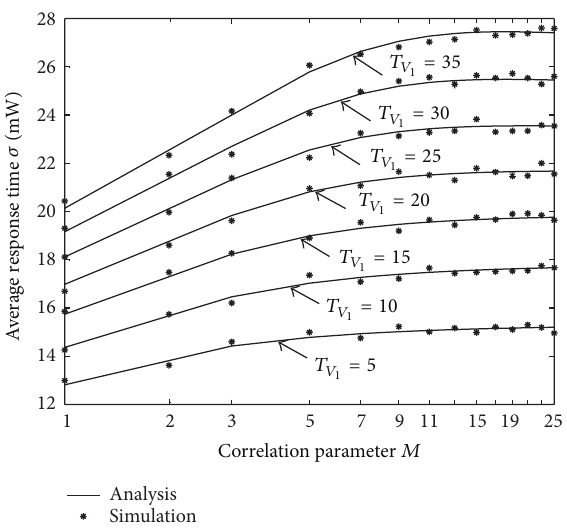
Figure 5: Average response time 𝜎 of data packets versus correlation parameter 𝑀 .